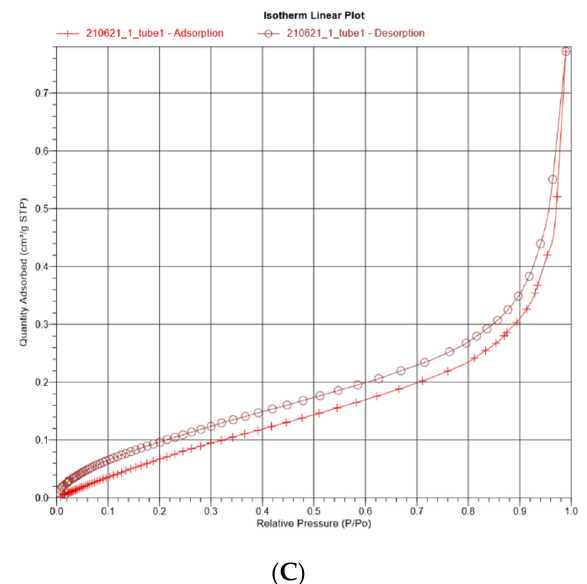
Figure 5. Isotherm linear plots explained by correlation between relative pressure and quantity adsorbed from ( A ) yellow soybean powder (YSP), ( B ) chickpea powder (CHP), and ( C ) egg white powder (EWP).